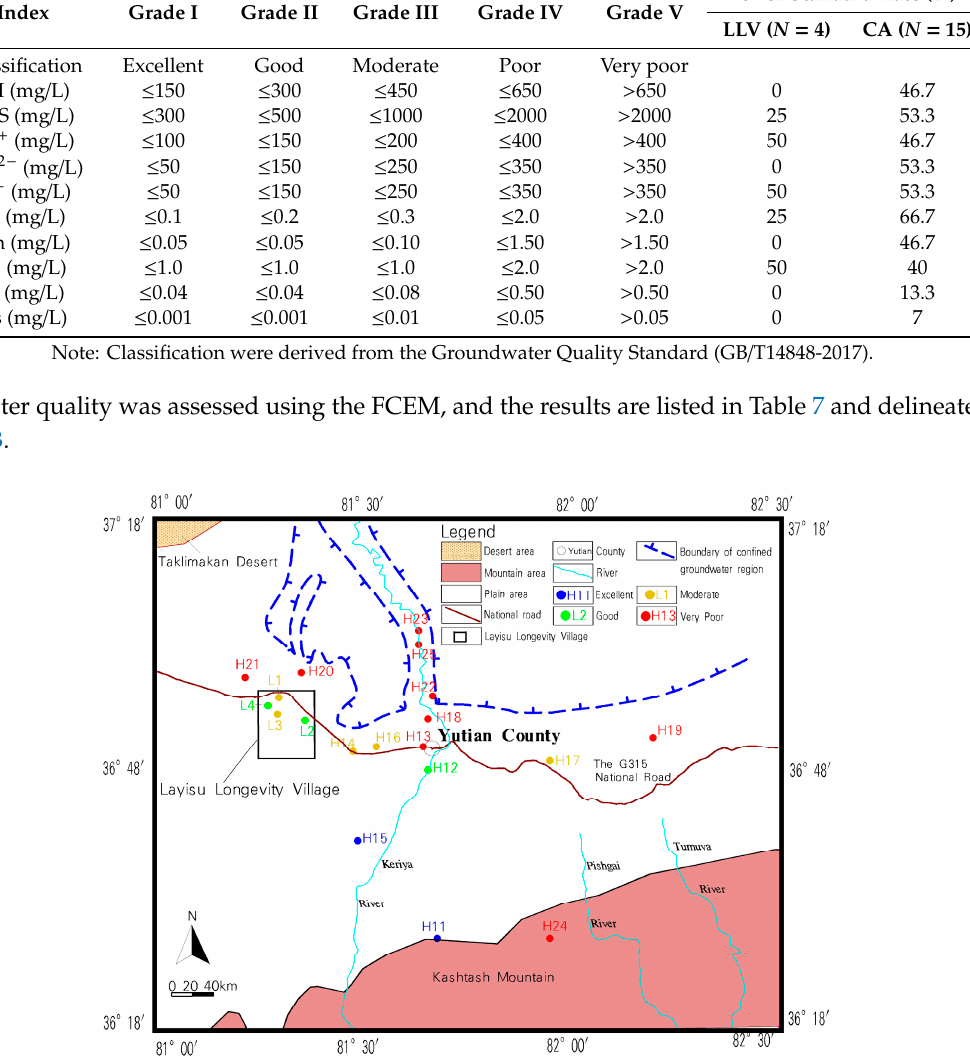
Figure 3. Results of water environment quality assessment on groundwater.